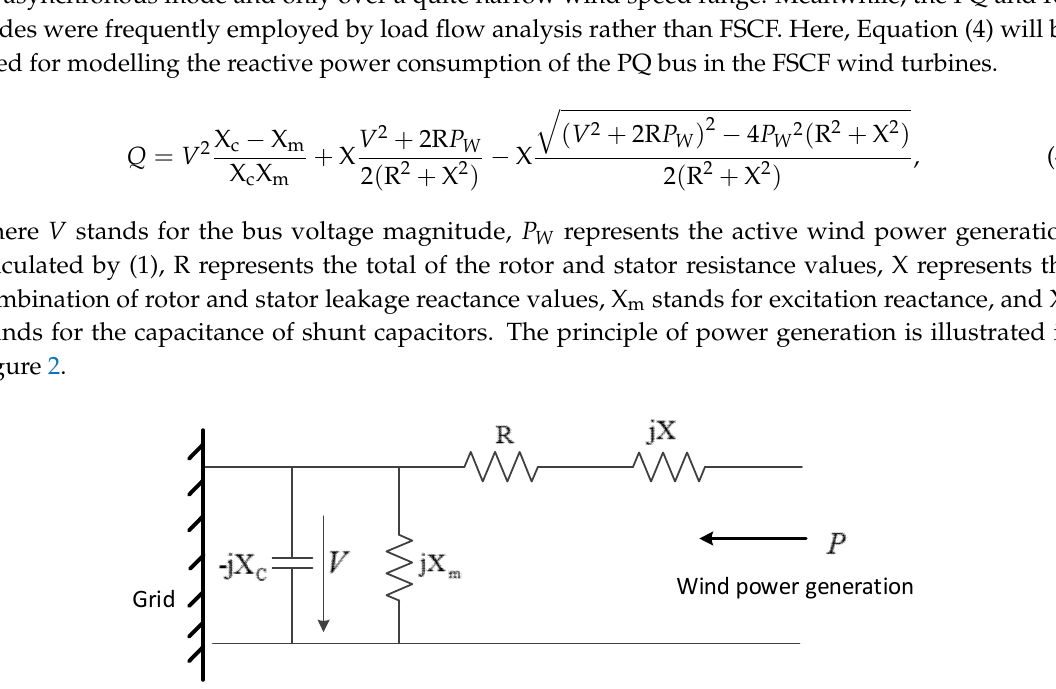
Figure 2. Simplified circuit of fixed speed/constant frequency type wind turbines.